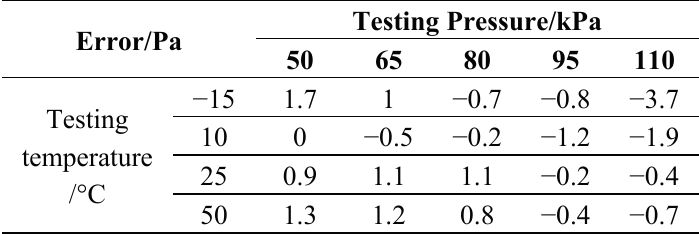
Table 1. The quantified errors at different pressure and temperature points. The maximal error measured was − 3.7 Pa, which was lower than ±0.007% F.S.